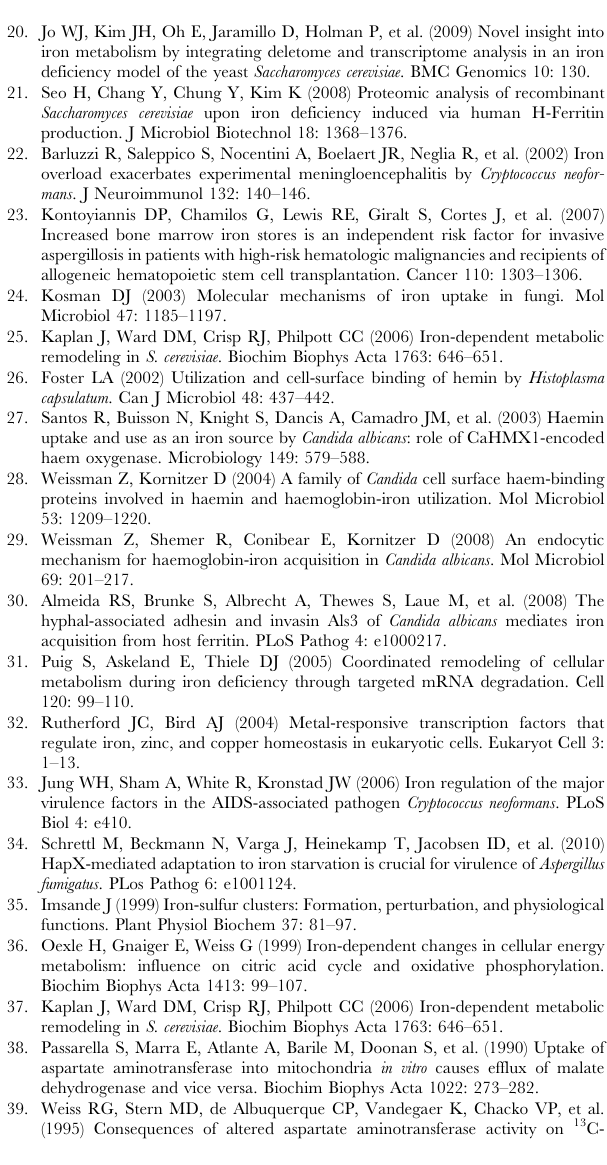
Figure S2 Categorical representation of regulated P. brasiliensis proteins following iron starvation. Identified proteins were classified according to their respective functional categories determined by MIPS. (A) Categorization of differentially expressed proteins during iron starvation. Classification of proteins with induced (B) and repressed expression (C) in iron limiting condition. (TIF) Table S1 Relative fold induction of iron metabolism related genes in the time course of iron starvation using real time- RT-PCR. 1 Values represent the mean of each triplicate sample 6 standard deviation. Table S2 Additional information about P. brasiliensis identified proteins with increased expression during iron starvation. ** Spots visualized only in iron-depleted condition. 1 Spots numbers refers to Figure 3. 2 p values were accessed by ANOVA statistical test.